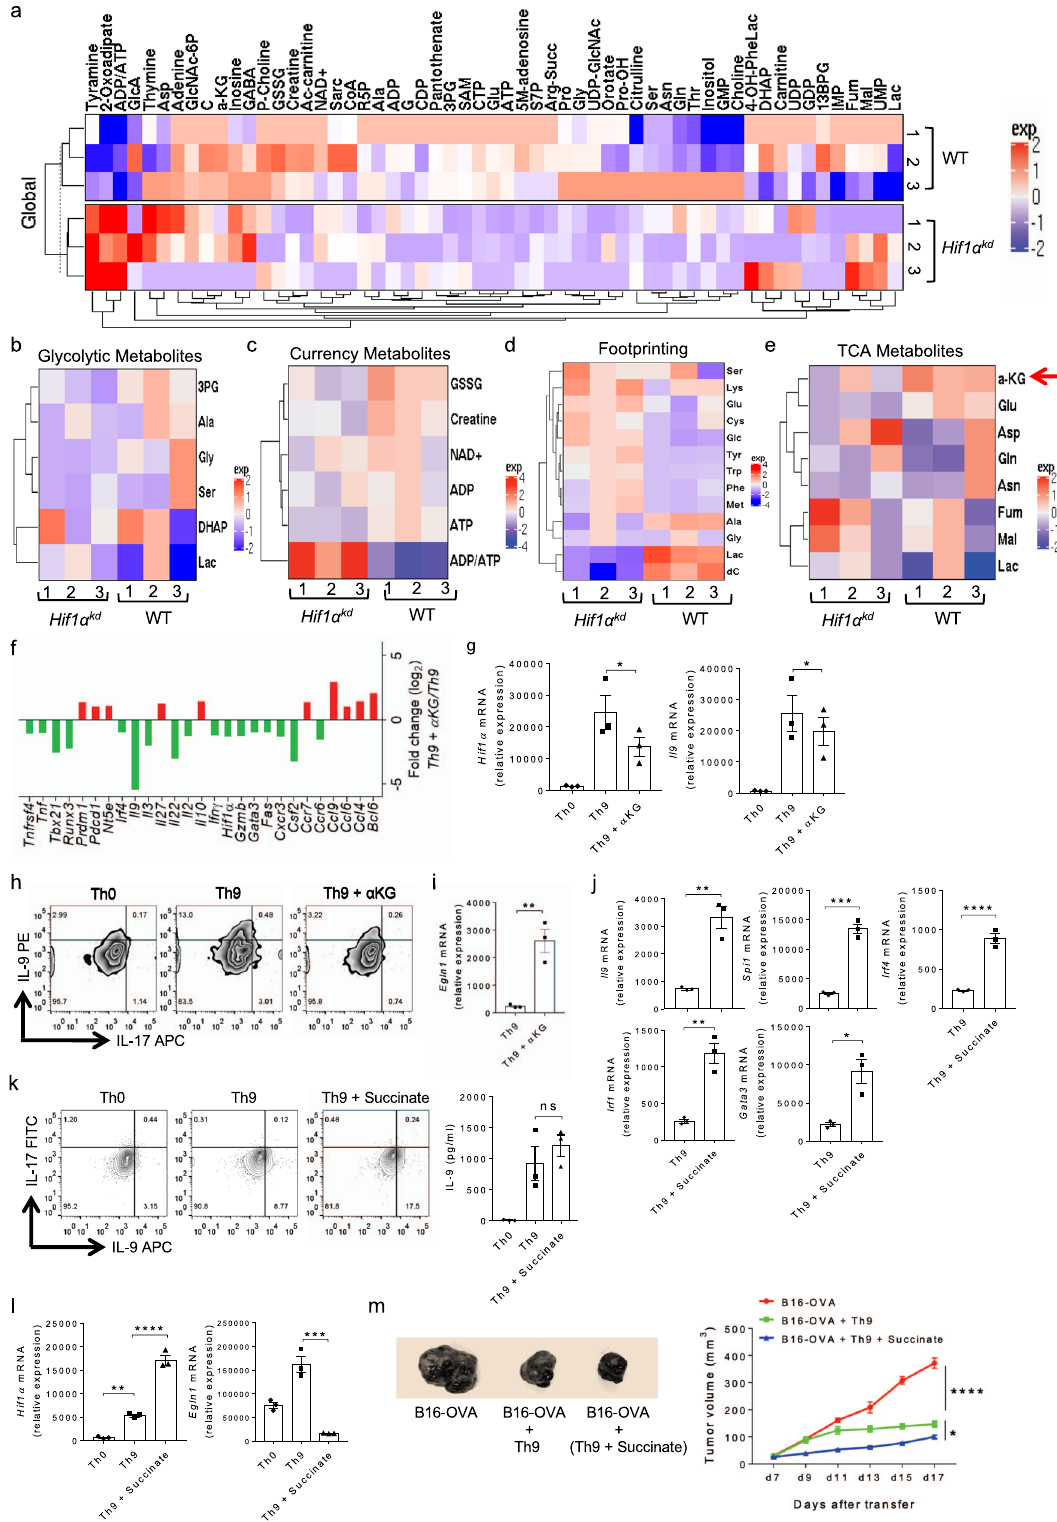
and unwanted low quality reads. Tophat2 and Bowtie2 packages were used to align the cleaned reads to the reference mouse genome (GRCm38). Subsequently, Htseq- count algorithm were used to measure gene expression from aligned reads. The read count-based gene expression data were normalized on the basis of library complexity and gene variation using the R package Cuffdiff. The normalized